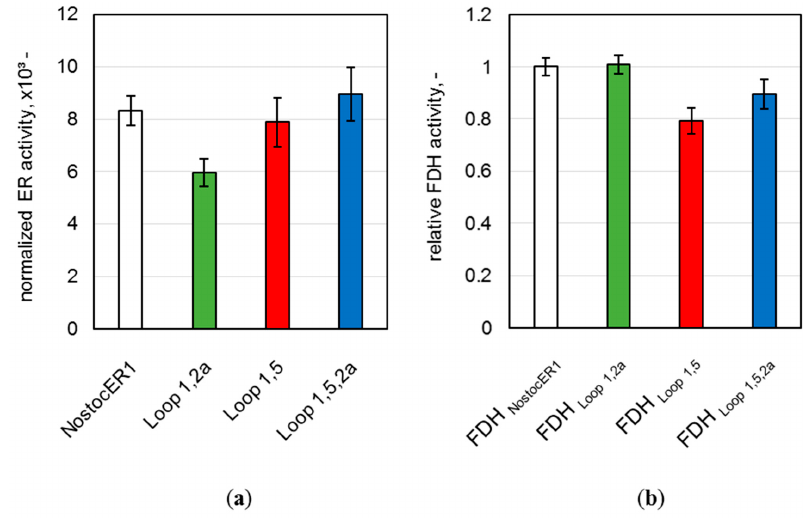
Figure 3. Activities in the supernatant of the disrupted E. coli cells after a process time of 48.3 h. ( a ) Ene reductase (ER) activity normalized to the activity of respective purified NostocER1-variant.